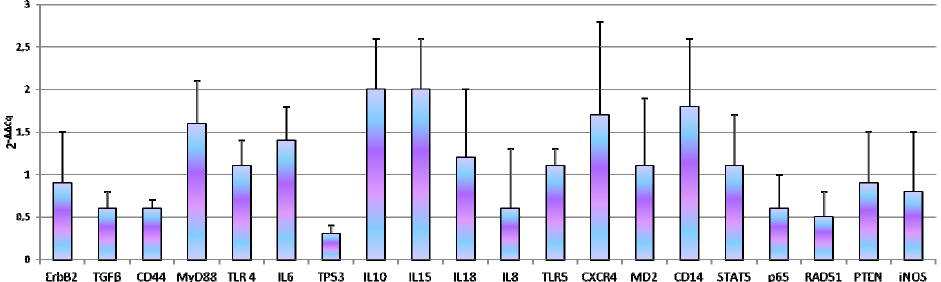
Figure 3. E ff ect of monolayer aging in D-17 cells. Data are expressed as 2 - ∆∆ Cq ; values are the mean of three test replicates ± 1 standard deviation and ∆∆ Cq = ∆ Cq (302nd passage at confluence plus 24 h of incubation at 37 ◦ C)— ∆ Cq (control 302th passage at confluence). Negative samples were given a Cq 39 fictitious value. Data were checked by Student’s t